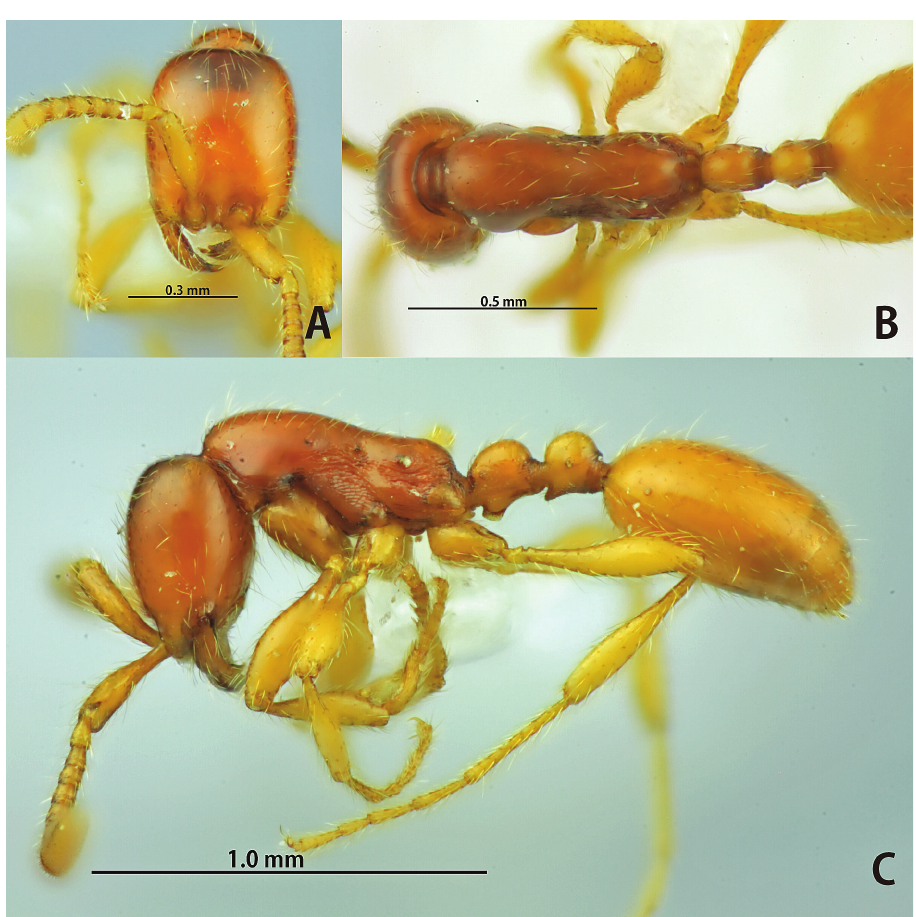
Figure 12. Aenictus longicephalus (holotype). A Head in full-face view B body in dorsal view C body in Propodeum in profile with feebly convex dorsal outline; propodeal junction rounded; declivity of propodeum slightly convex, with blunt lateral carinae but not demarcated basally by a transverse carina. Petiole almost as long as high, with its dorsal outline convex; subpetiolar process low and subrectangular. Postpetiole slightly smaller than petiole, with its dorsal outline roundly convex.